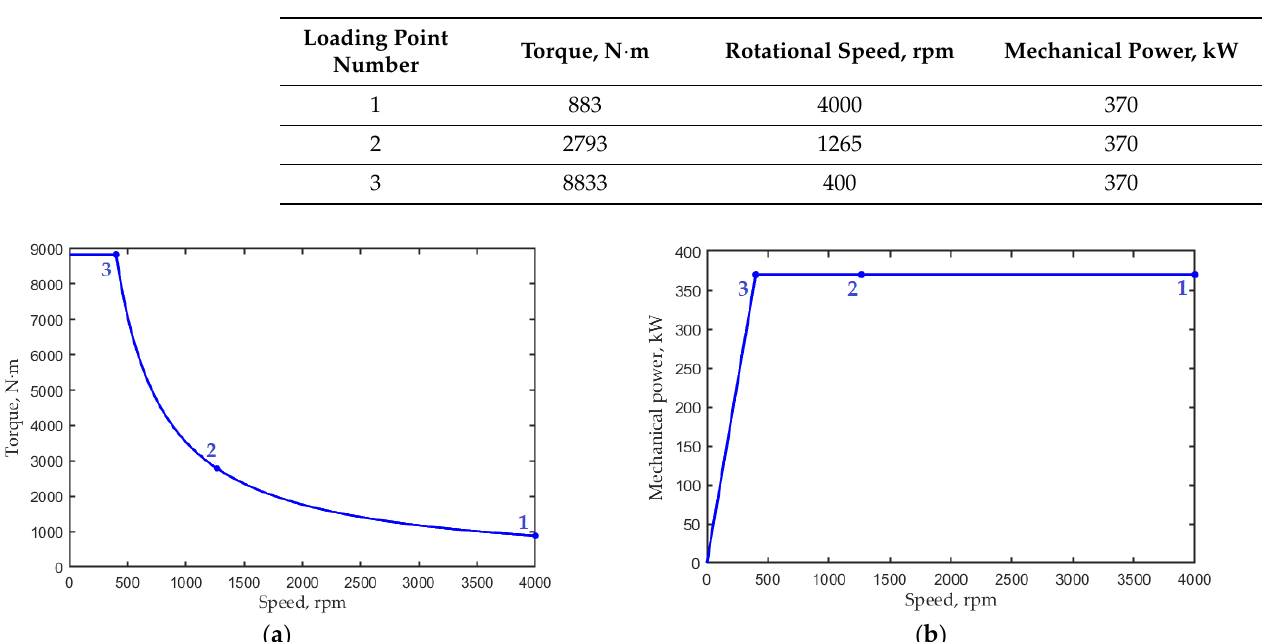
Table 1. Operating points of the traction motor considered during optimization.